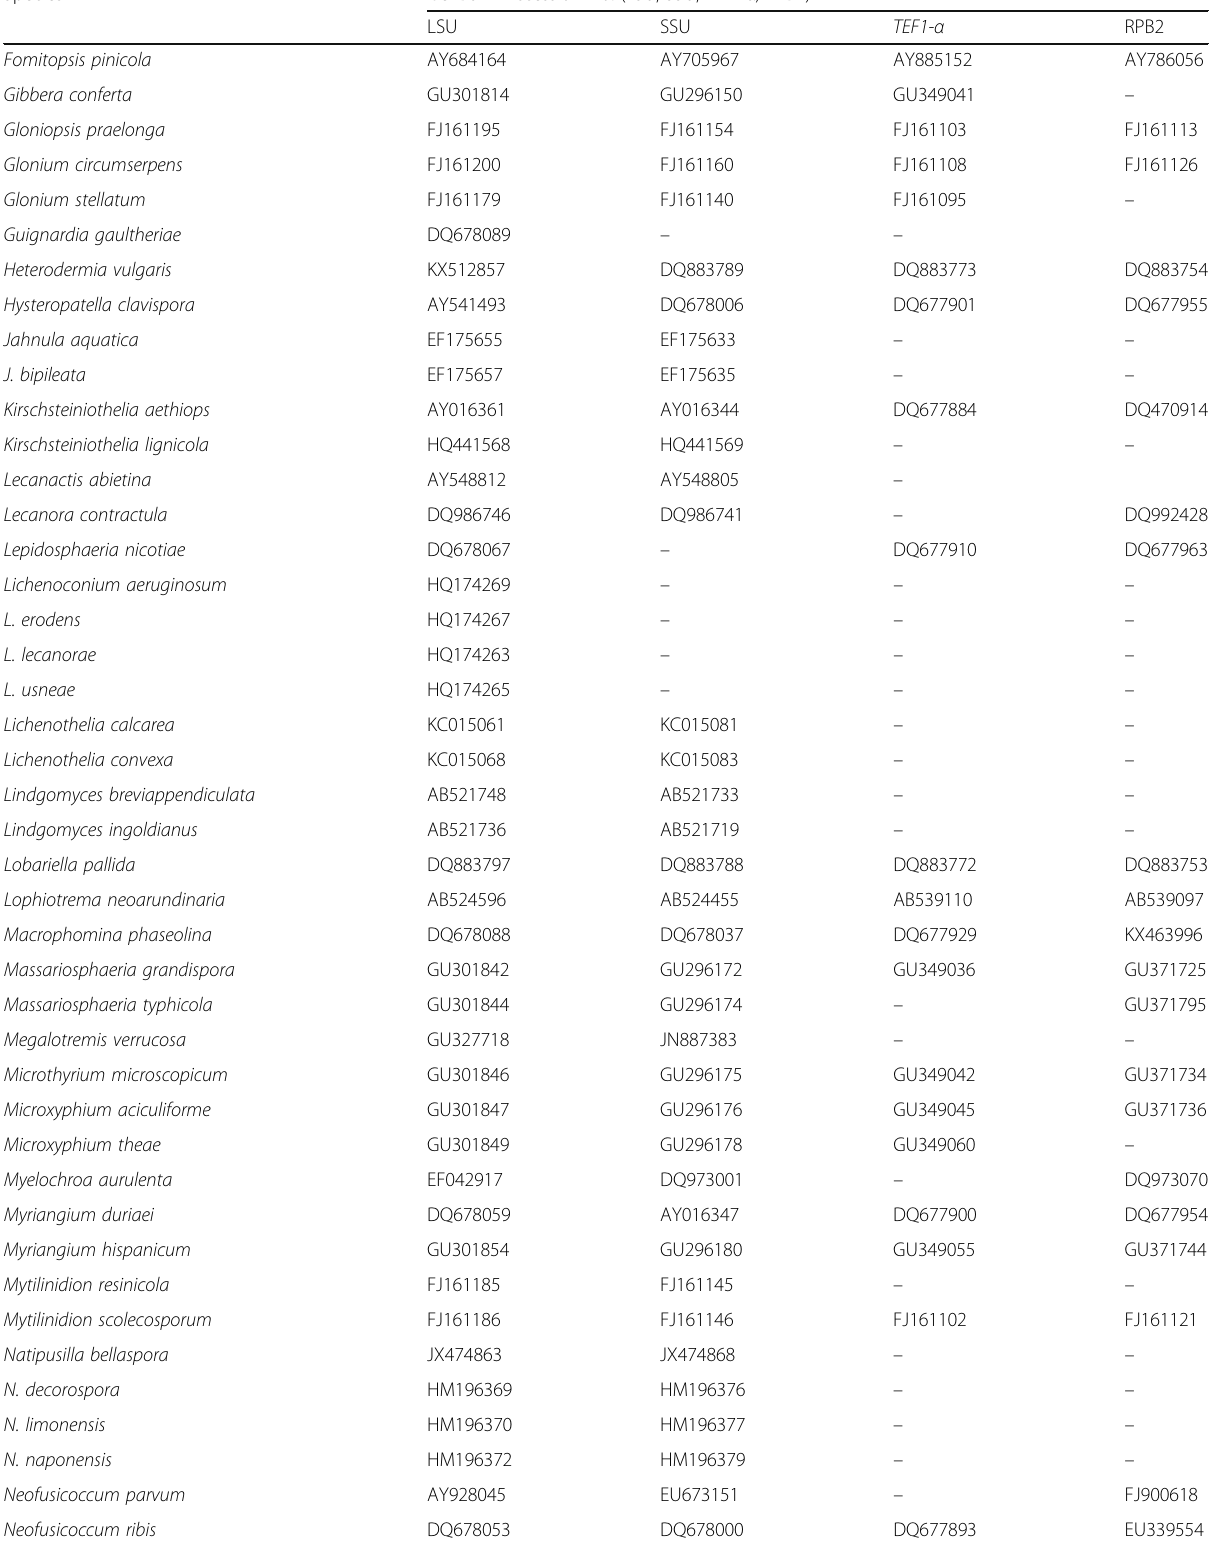
Table 3 Other sequences retrieved from GenBank for phylogenetic analysis (Continued)